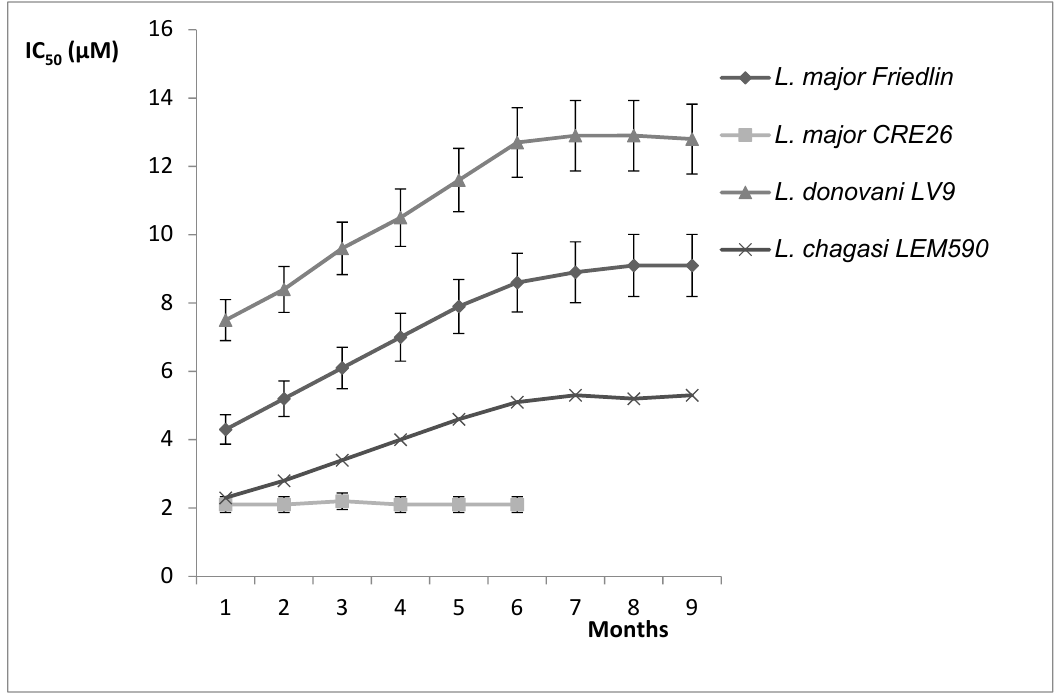
Figure 7. Kinetics of Leishmania sp . susceptibility to 2 -n- propyl quinoline hydroxypropyl beta-cyclodextin under in vitro stepwise drug pressure [73].